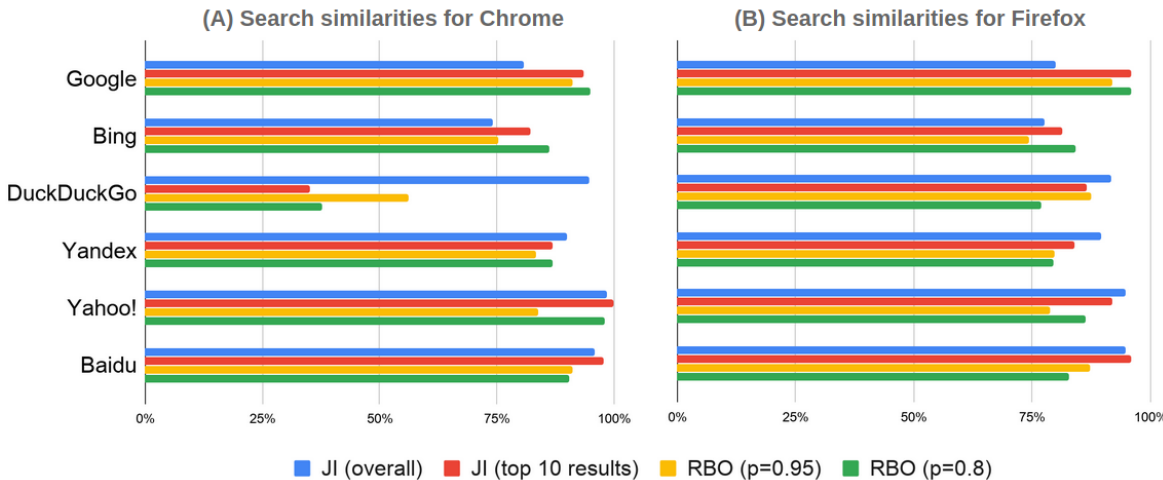
Figure 2. Average similarities (%) in search results for pairs of agents using the same search engine. JI stands for the Jaccard index and RBO stands for the Ranked Biased Overlap. The x-axis shows the average percentage for each of the similarity metrics, and the y-axis shows the pairs of search engines that are